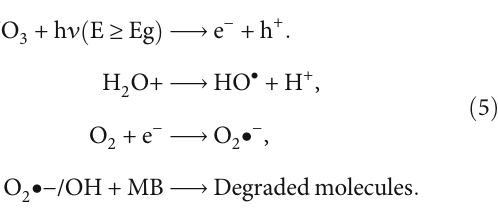
nanoparticles (a) wide, (b) O1s, (c) C1s, and (d) 3